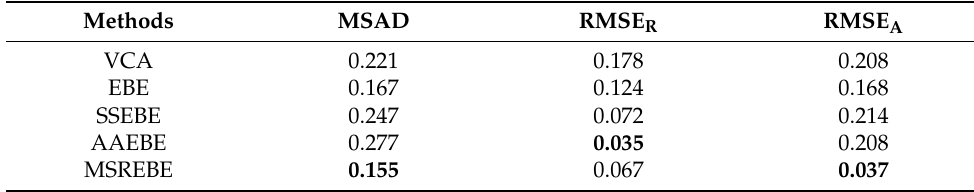
Figure 7. The abundance estimation results of synthetic dataset. Table 1. Experimental results of synthetic image dataset.